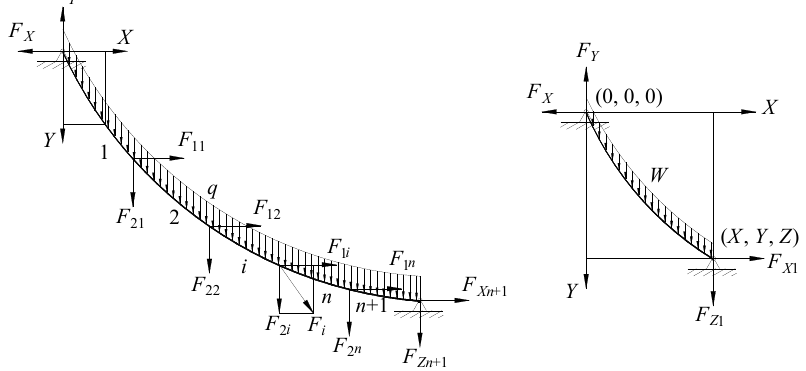
Figure 4. Forced state of cable at the completion state.